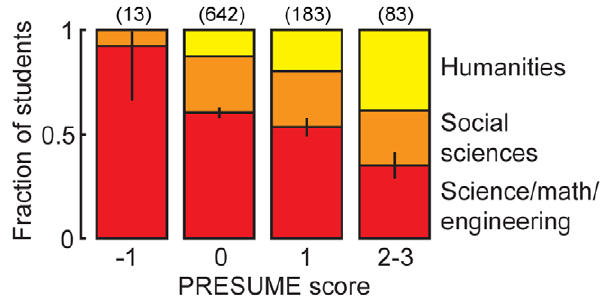
Figure 2. Relationship between subject matter preference and familial neuropsychiatric disorders. The PRESUME score was calculated as familial bipolar + depressive + substance abuse – ASD, with a maximum of one point per category. Error bars indicate 68% binomial proportion confidence intervals on the science/math/engi- neering fraction. The number in parenthesis indicates respondents in that category.